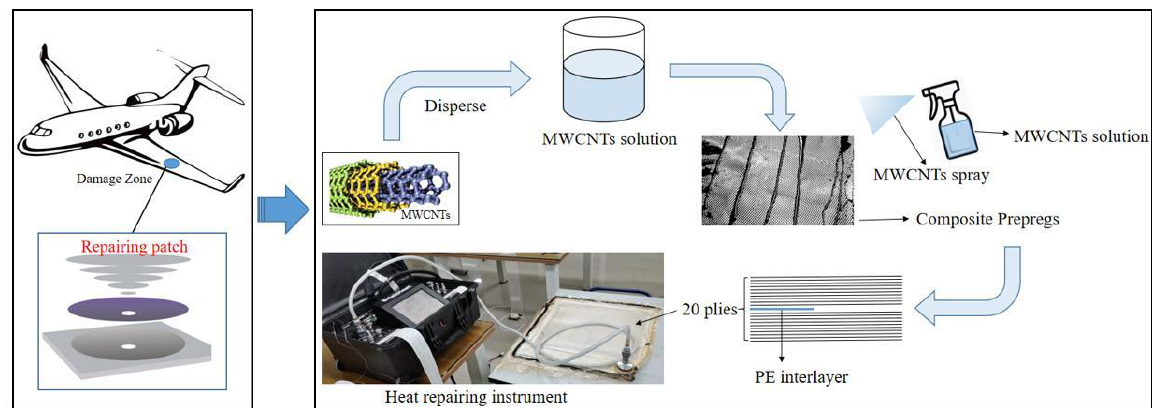
Figure 1. Illustration of the MWCNTs-based field-repair strategy.